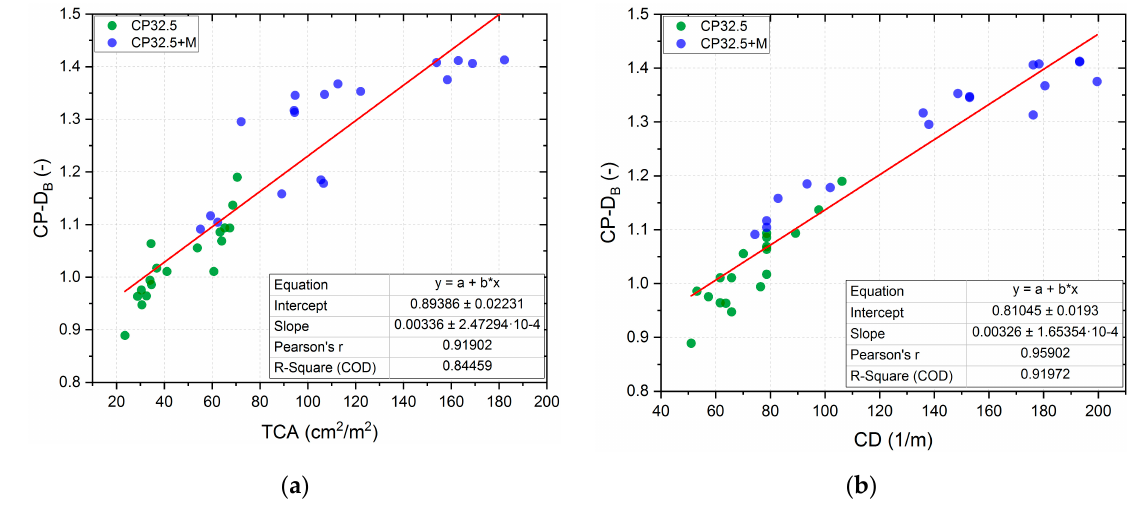
Figure 9. Analysis of the linear regression of CP-D B in function of: ( a ) TCA ; ( b ) CD .